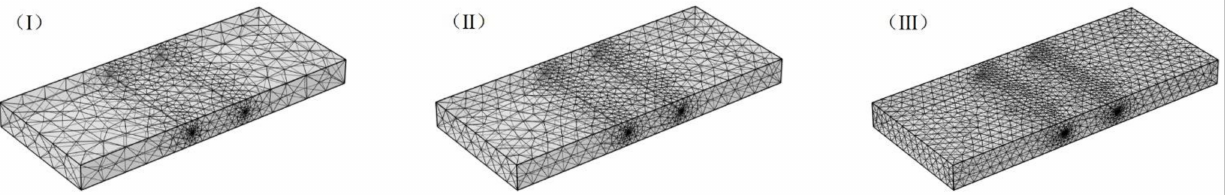
Figure 17. Mesh division types: ( I ) normal; ( II ) fine; ( III ) finer.